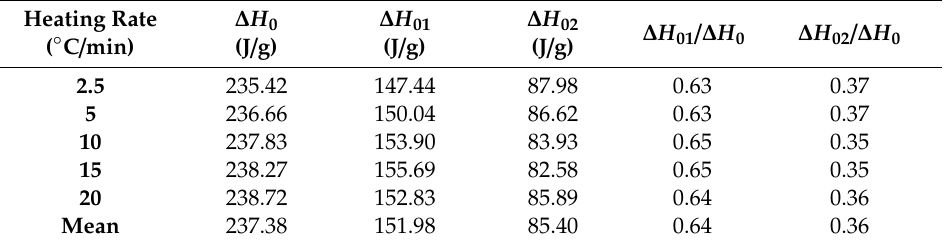
Figure 3. DSC thermograms of P-ddm / APbPc blends at di ff erent heating rates ( A ), Lorentz fitting of P-ddm / APbPc blend curve at 2.5 K / min ( B ), reaction 1 curves ( C ), and reaction 2 curves ( D ) at di ff erent heating rates. Table 2. The proportions of two reactions in P-ddm / APbPc blends at di ff erent heating rates.